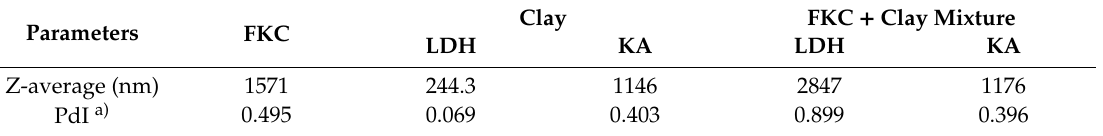
Table 1. Dynamic light scattering results of FKC, clays, and FKC + clay mixture. Clay FKC + Clay Mixture Parameters FKC LDH KA